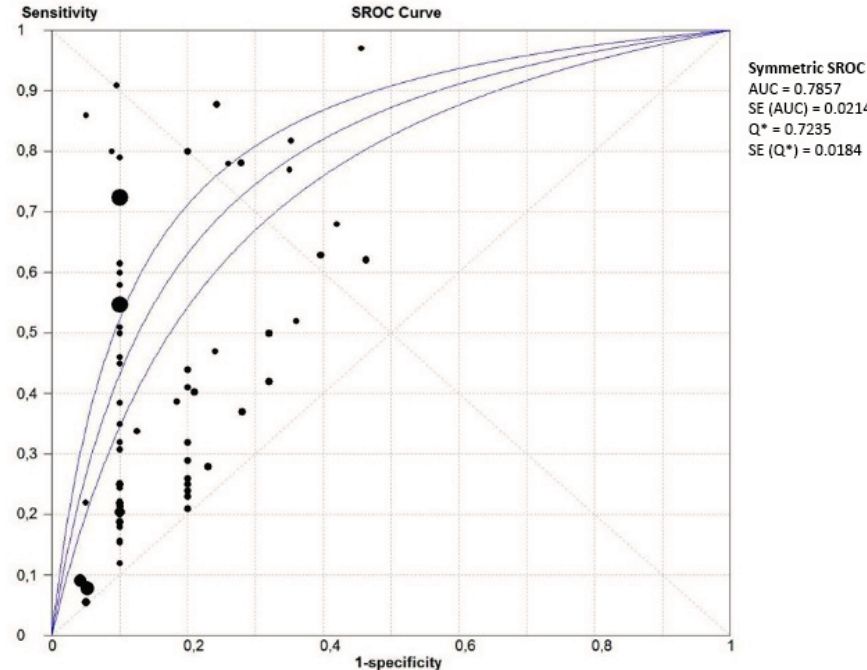
Figure 5. Summary of receiver operating characteristics curve of single